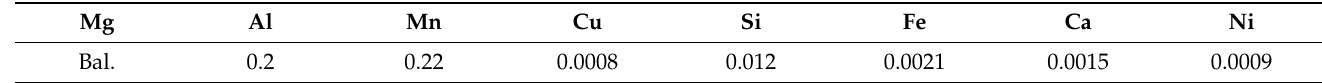
Table 2. Chemical composition of Al1060 (mass fraction, %).